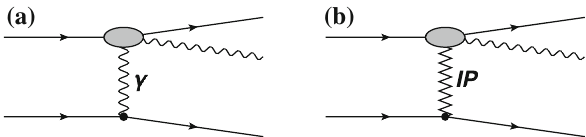
Fig. 1 The bremsstrahlung process diagrams: a electromagnetic pro- cess, b diffractiveprocess.The blobs indicateamixtureofvariousmech- anisms of photon